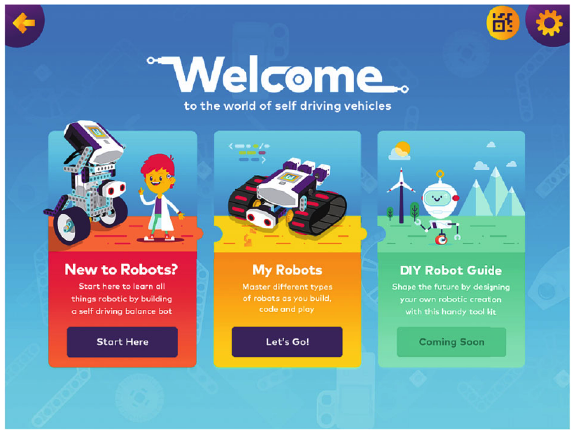
Figure 5: Multimedia intelligent question-answering and self- testing system UI